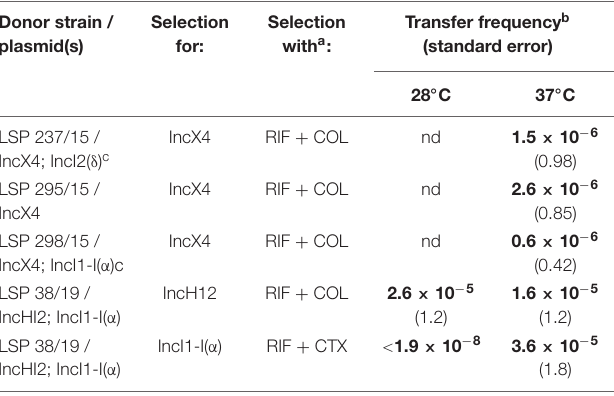
TABLE 2 | Conjugation/mobilization frequencies of IncX4, IncHI2, and IncI1-I( α ) plasmids of food-borne colistin resistant isolates of the monophasic ST34 variant of Salmonella enterica serovar